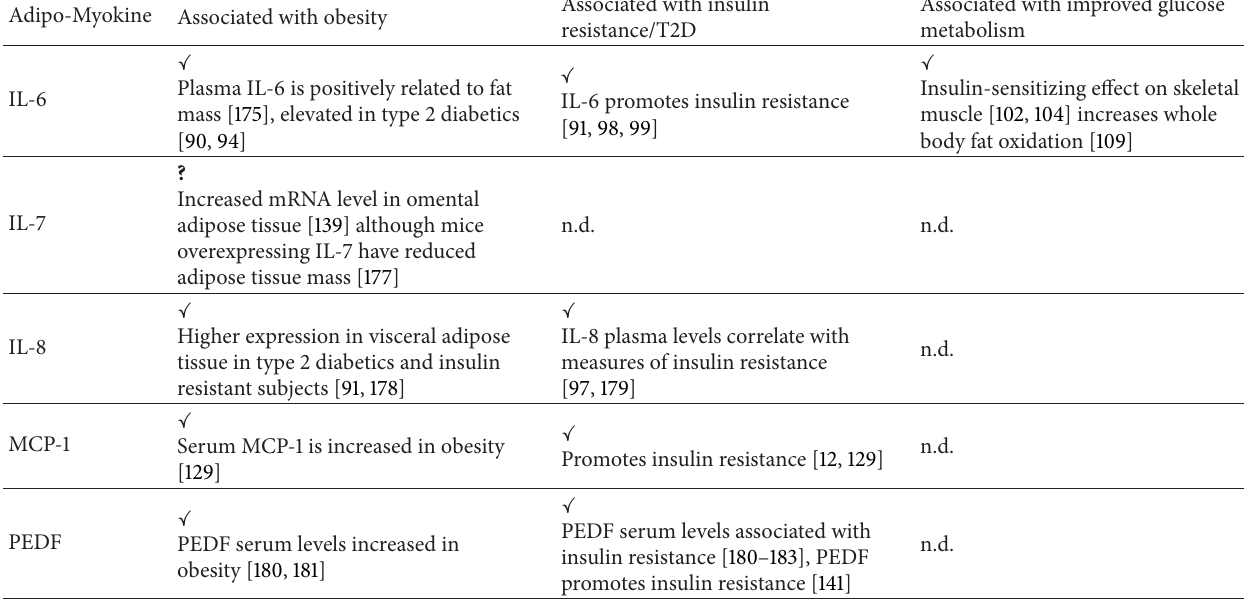
Table 3: Concentrations of various factors in conditioned medium from primary human adipocytes and primary human myotubes. Primary human skeletal muscle cells were differentiated for 5 days and primary human preadipocytes were differentiated for 14 days in vitro to mature cells. During the last 24 h cells were incubated with serum-free medium to obtain conditioned medium. Concentrations of secreted factors from cells within this conditioned medium were analyzed by enzyme-linked immunosorbent assay. Data are means ± SEM, 𝑛 ≥ 3